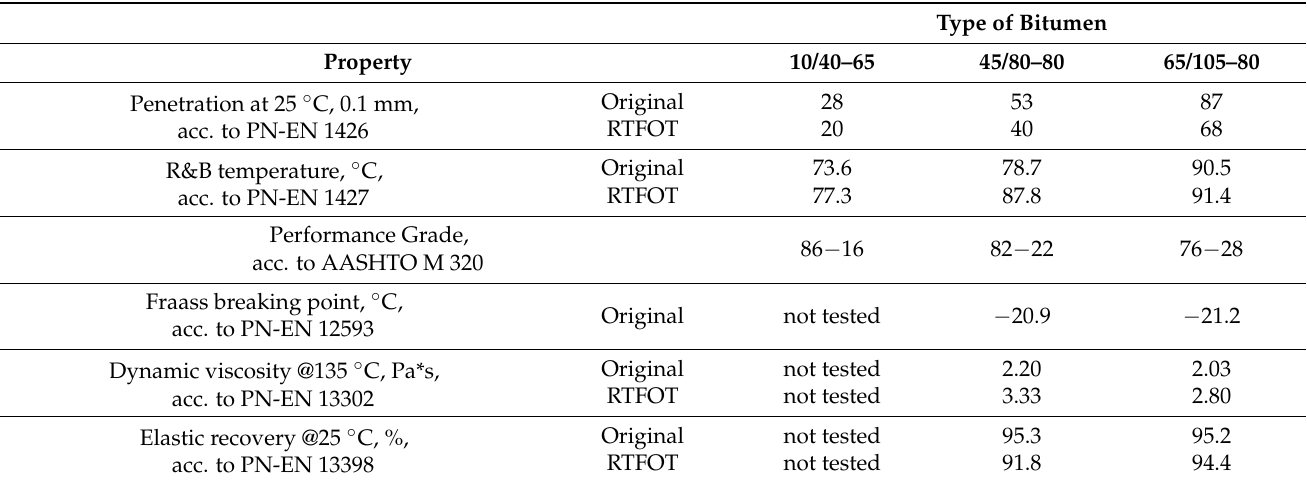
Table 2. Properties of bitumens.